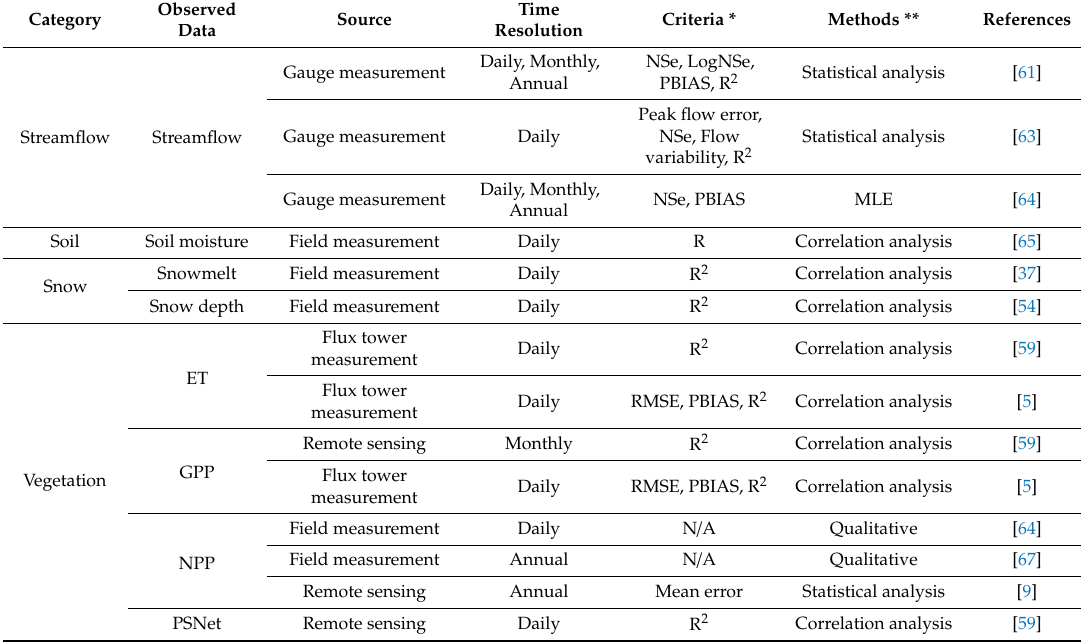
Table 3. The details for validating RHESSys in existing